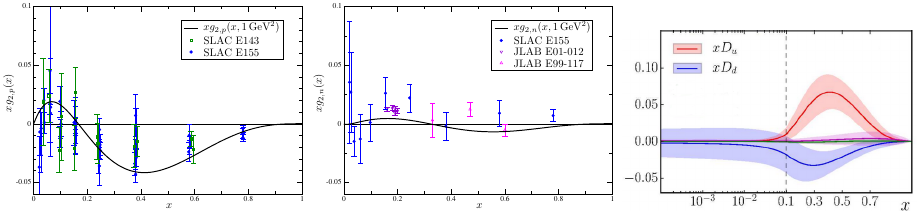
Figure 2. Left and middle panels: The structure function g 2 ( x , Q 2 ) for the proton and the neutron, respectively. Right panel: The twist-three contributions D ( x , Q 2 ) for the u -quark and the d -quark in the proton. Figure adapted from